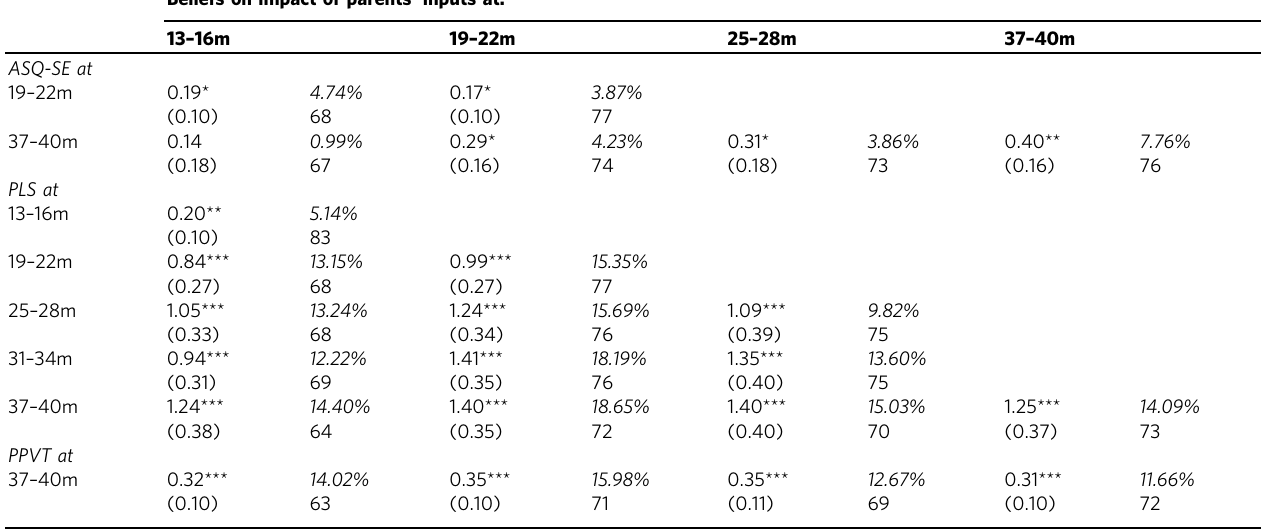
The rows correspond to children ’ s skills measured at fi ve different time points. ASQ-SE stands for Ages and Stages Questionnaire: Social Emotional, PLS stands for Preschool Language Scale, and PPVT stands for Peabody Picture Vocabulary Test (see Supplementary Information, section 4.3). They are regressed on parents ’ beliefs measured at four different time points, in separate simple linear regressions.Boththechildoutcomevariablesandthebeliefsvariablesarestandardized.Foreachregression,thetablegivesthecoef fi cientofthebeliefsmeasure,itsstandarderrorinparenthesesbelow, the R -squared in italics next to the coef fi cient, and the number of observations below the R -squared. *For p -value<0.1, **for p -value<0.05, ***for p -value<0.01. p -values are based on two-sided Student ’ s t tests without adjustment for multiple